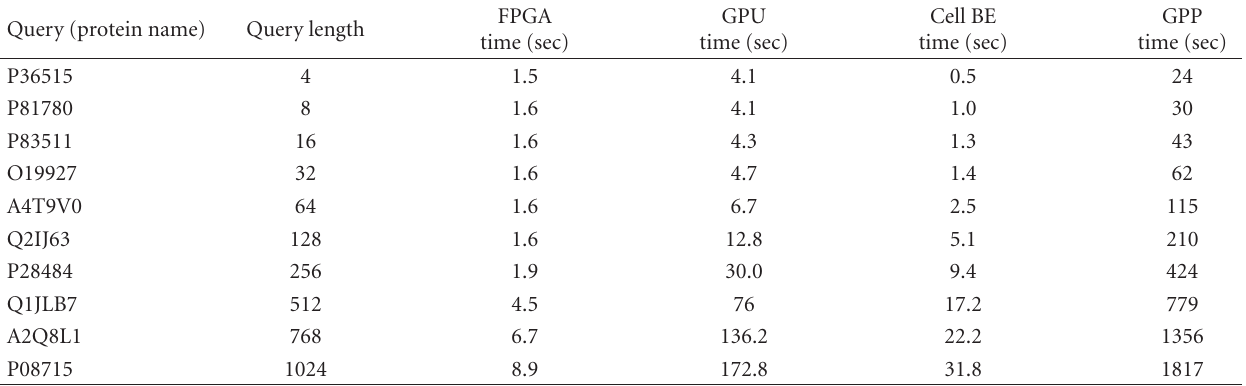
Figure 12: Illustration of the Smith-Waterman calculation on the Cell BE. Table 3: Performance comparison. All query sequences run against the SWISS-PROT